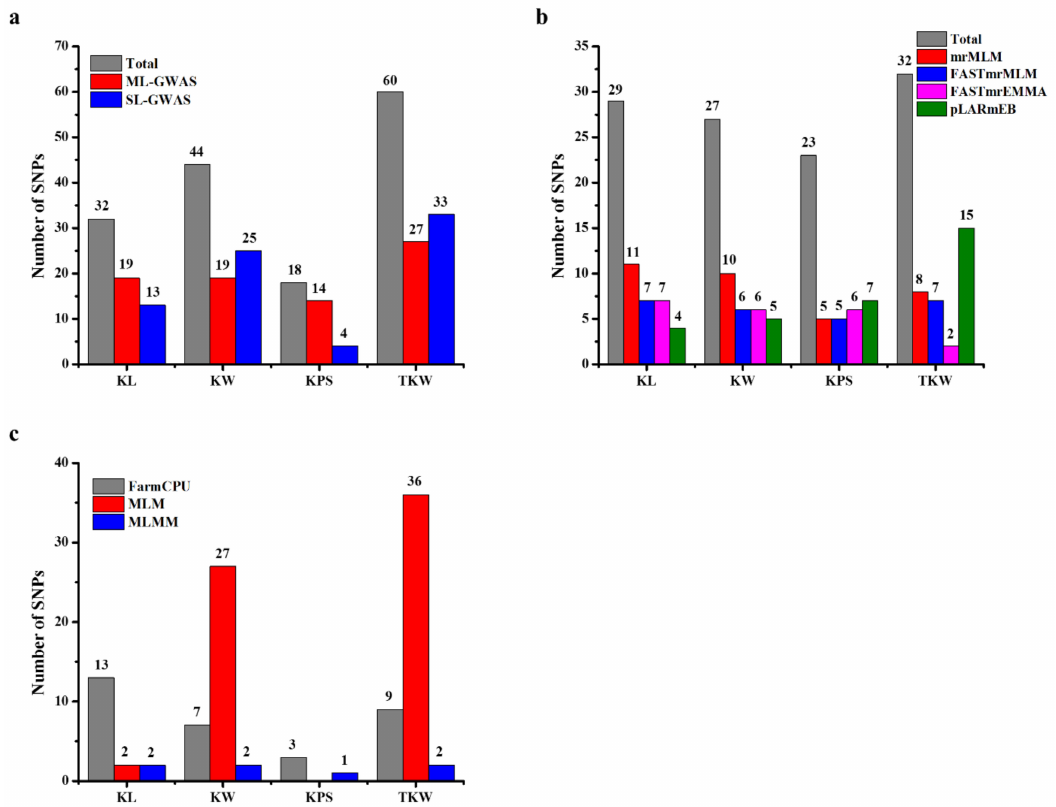
Figure 3. Significant single nucleotide polymorphisms (SNPs) detected by di ff erent multi-locus genome-wide association study (ML-GWAS) and single-locus GWAS (SL-GWAS) methods for the Kernel traits of the Kernel length, Kernel width, Kernels per spike, and thousand kernel weight: ( a )NumberofdetectedSNPsthroughML-GWASandSL-GWASmethods; ( b )numberofsignificantSNPs detected by ML-GWAS methods including mrMLM, FASTmrMLM, FASTmrEMMA, and pLARmEB; and ( c ) ignificant SNPs detected by SL-GWAS methods including FarmCPU, MLM, and